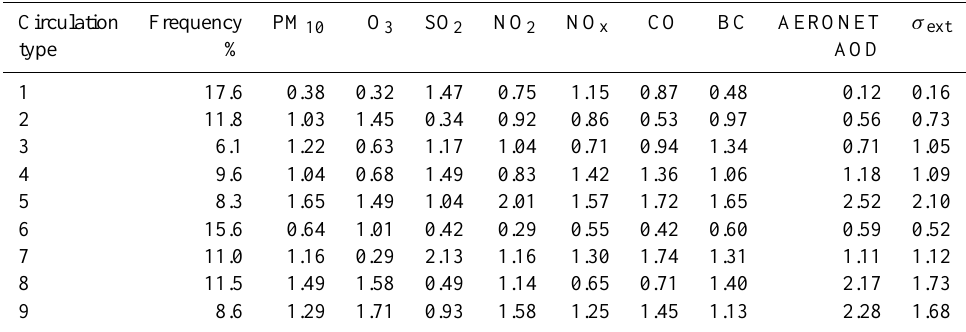
Table 2. Relationship between weather types and high pollution episodes in Beijing. The standardized ratios of the percentage of days in the upper 20% for PM 10 , O 3 , SO 2 , NO 2 , NO x , CO, BC, AERONET AOD, and extinction coefficients (calculated from the visibility) to the overall percentage of occurrence of the particular circulation type are